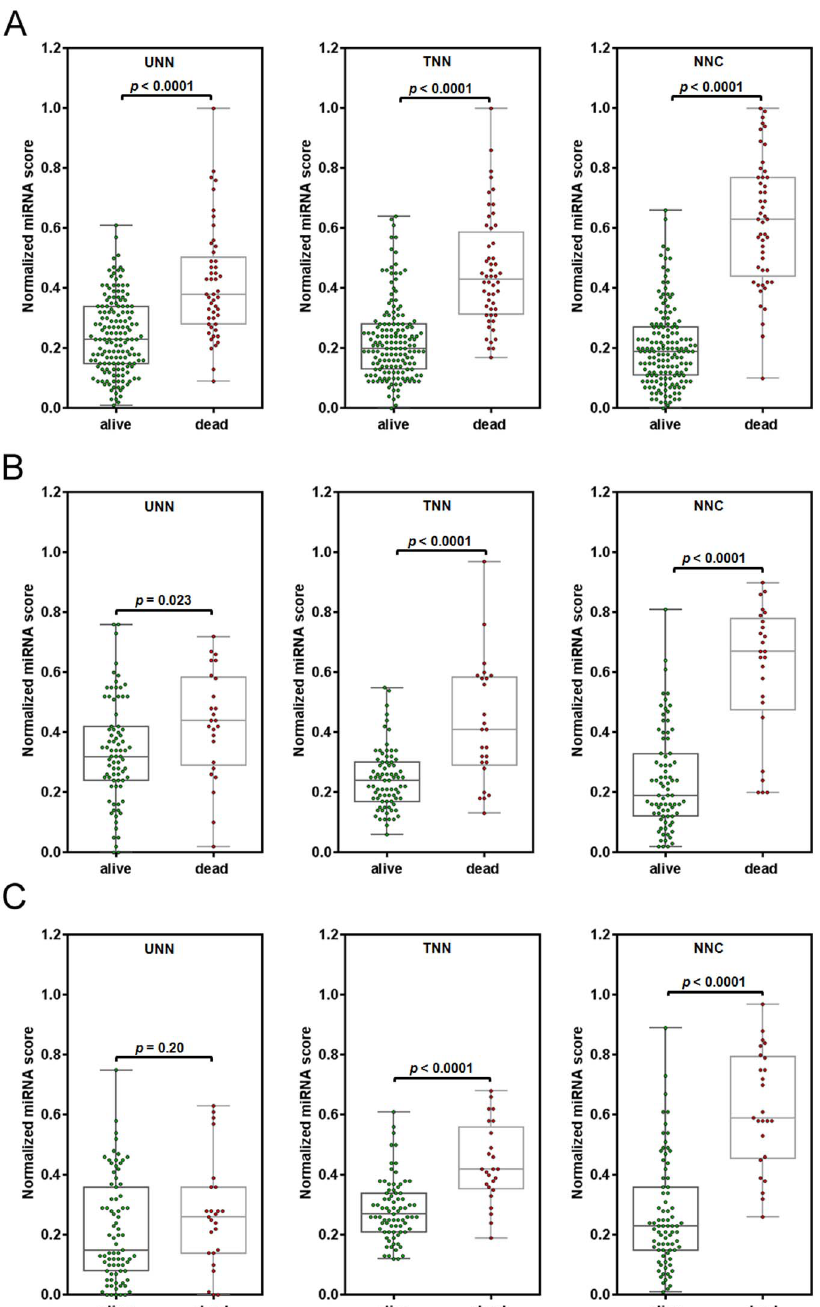
Figure 4. Scatter plots of miRNA scores exported from different ANN models (normalized). Comparisons of miRNA scores were performed between patients with different survival statuses in the model training set ( A ) and the external validation sets with normal miR-93 expression input ( B ) and with disturbed miR-93 expression input ( C ). UNN: untransformed neural network; TNN: transformed neural network; NNC: neural network